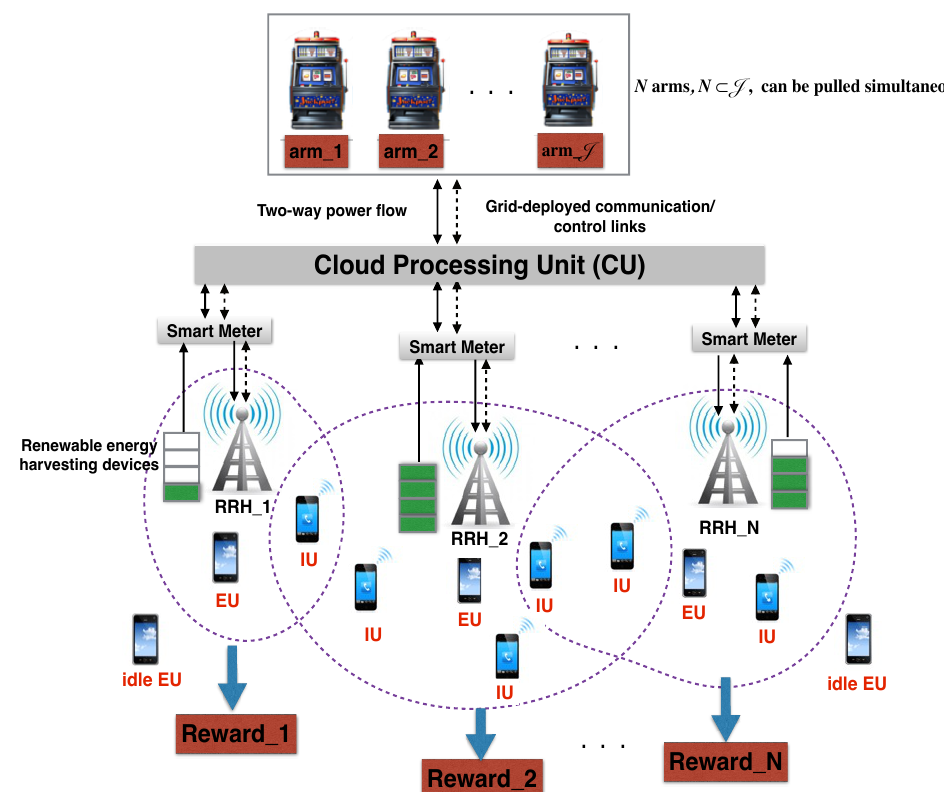
Figure 1. Combinatorial multi-armed bandit (CMAB) problem for predictive real-time energy trading in a cloud radio access network (Cloud-RAN) with the sparse beamforming